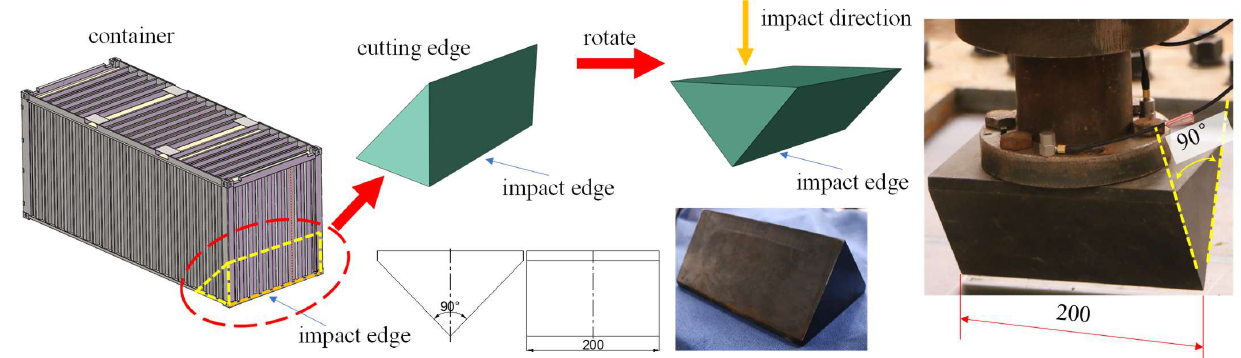
Figure 2. TEU (twenty feet equivalent unit) container and the rigid impactor.